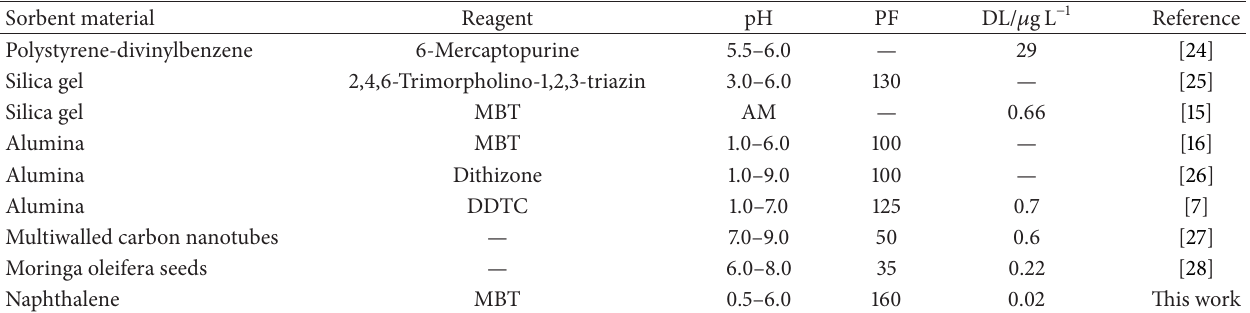
Table 3: A comparison between the figures of merit of the proposed method with similar SPE methods for Ag determination by FAAS. Sorbent